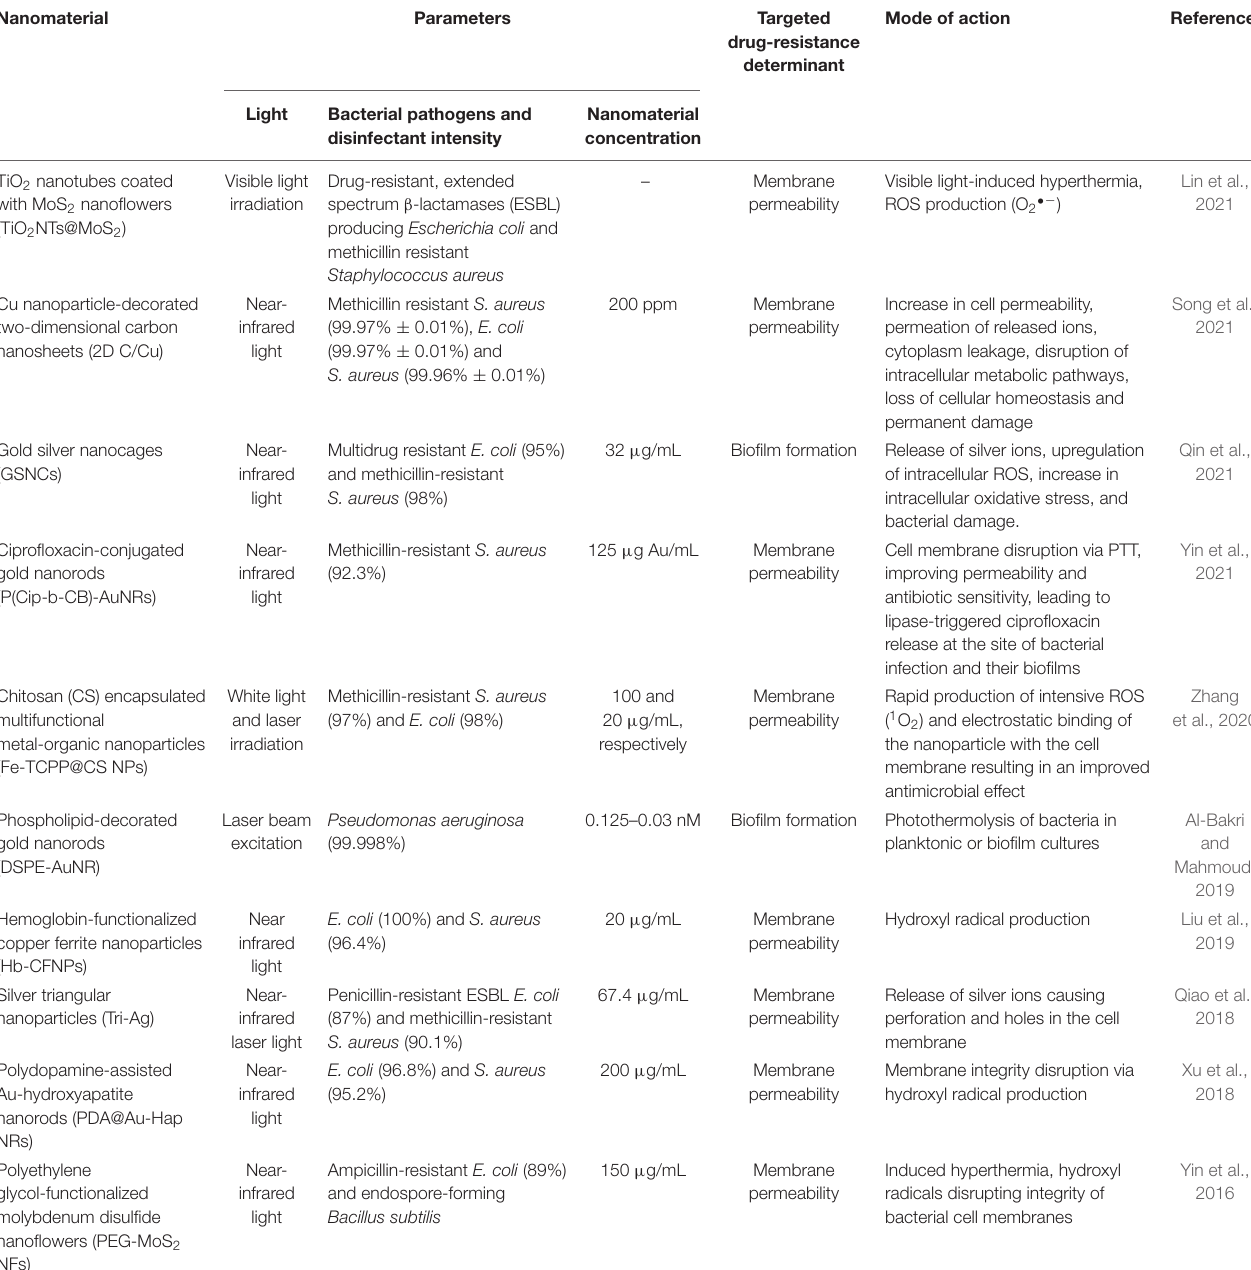
TABLE 1 | Photothermally active nanomaterials against bacteria with targeted drug-resistant